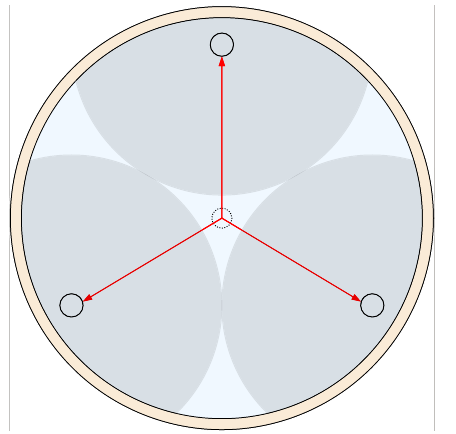
Fig. 1 Bottom horizontal sketch of one Mercedes WCD. The 3-PMTs are placed in a 120 ◦ star configuration. The dark grey areas represent the Cherenkov light pools of muons injected vertically in the tank in the direction of the PMTs. The dotted small circle at the centre indicates the possible location of an additional PMT placed at the top of the tank (see text). The existence of a possible thermal insulation layer connected to the lateral walls is represented in